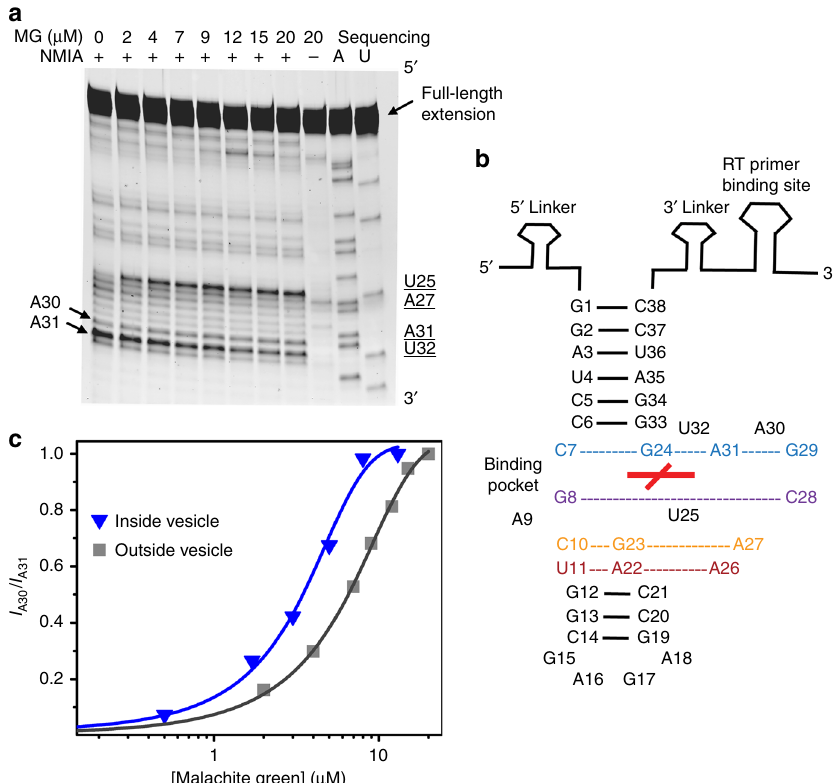
Fig. 5 Conformational probing of the MG aptamer. a Representative SHAPE gel (MG aptamer exposed to empty MA vesicles). The fi rst eight lanes show SHAPE reactions containing NMIA at increasing MG concentrations. The ( − ) lane shows a negative control containing 20 μ M MG but in which no NMIA was added. The two rightmost lanes show A and U sequencing reactions performed using ddTTP and ddATP as chain terminators, respectively. The sequencing lanes give bands that are one nucleotide longer than the corresponding NMIA lanes. b Scheme showing the aptamer SHAPE construct and the MG-aptamer structure determined previously 45 . The red cross in the center indicates the position of the MG ligand. Base pairing in stem regions (solid black lines) and other interactions (dotted lines) are shown. c Leftward shift in band intensity ratio between A30 to A31 at varying concentrations of MG when the aptamer is encapsulated in MA vesicles (blue triangles) vs. exposed to empty MA vesicles (gray squares). Representative concentration series are shown. Lines show curve fi ts to the Boltzmann